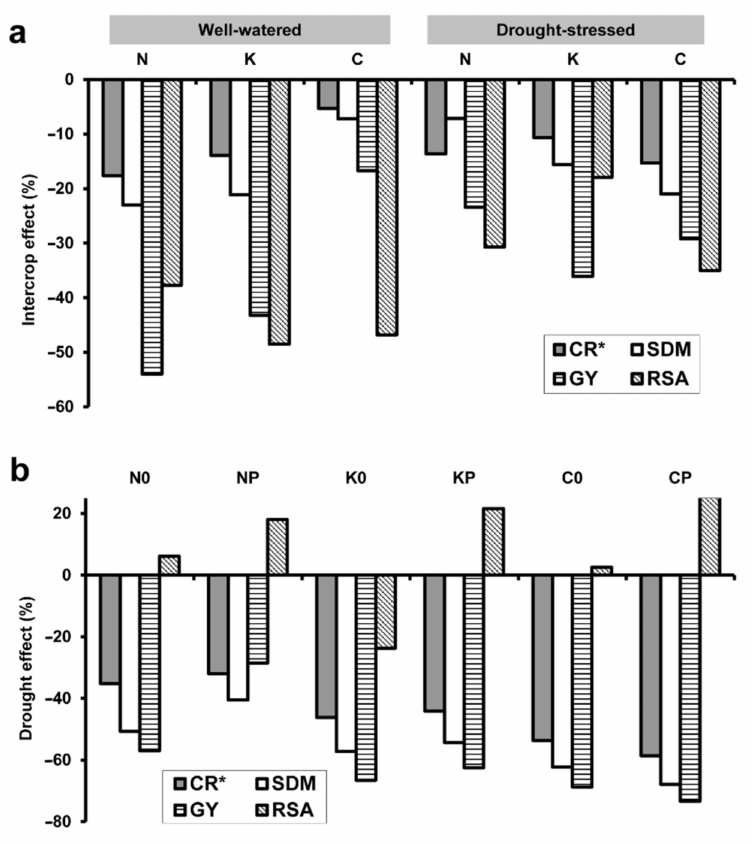
Figure 5. Percentage changes in the apparent root electrical capacitance (C R *), total shoot dry mass (SDM) and total grain yield (GY) of wheat and in the root surface area (RSA) caused by ( a ) pea intercropping and ( b ) drought stress. In the case of C R * and RSA, maximum values (detected at the wheat flowering stage) were used for calculation. For treatment codes, see Figure